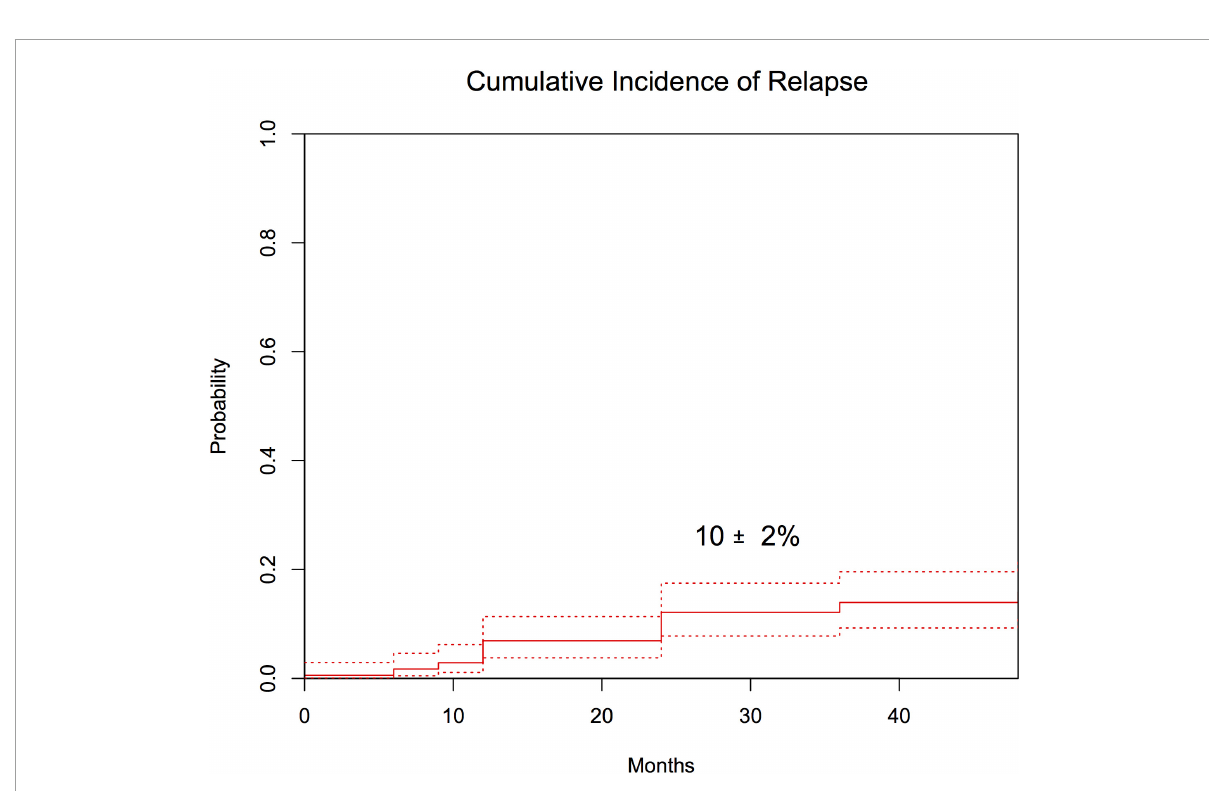
FIGURE4 Cumulative incidence of CIR after 1 year